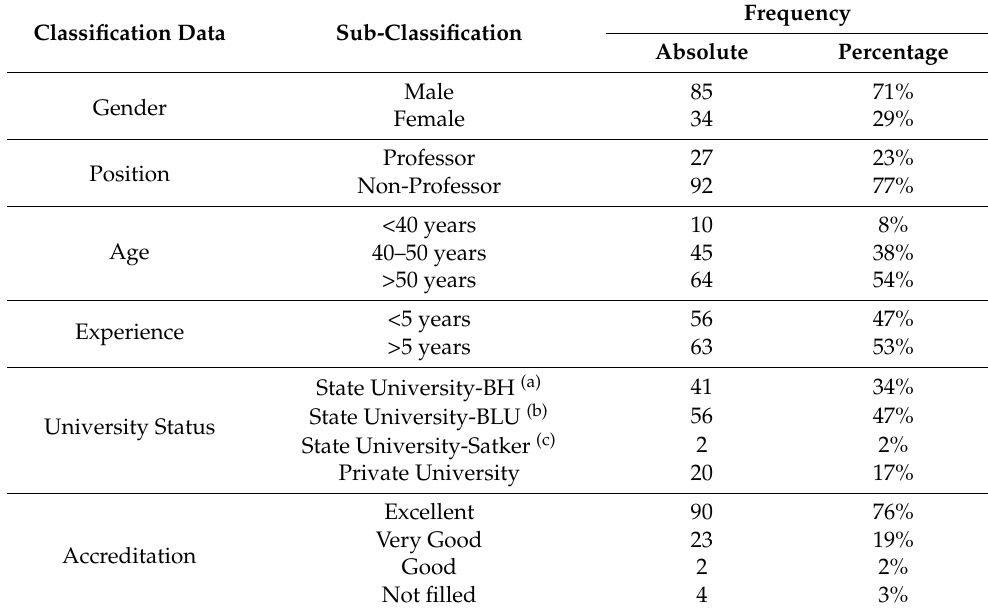
Table 3. Characteristics of